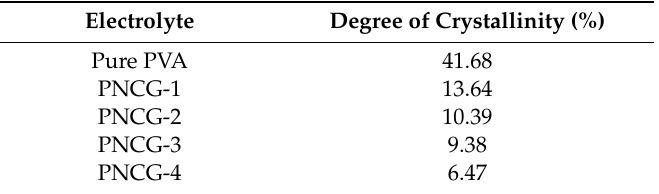
Table 1. The degree of crystallinity from deconvoluted XRD